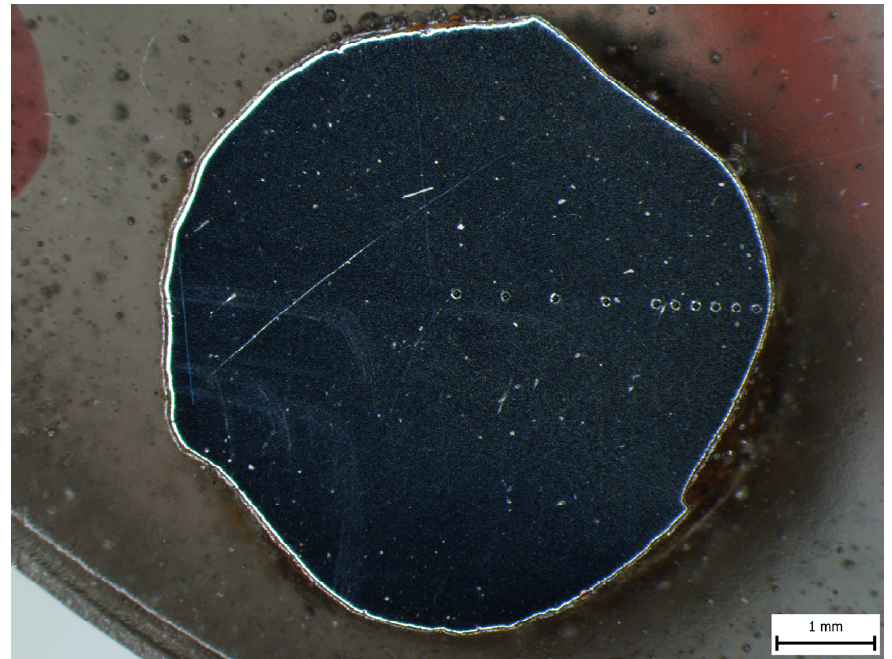
Figure 2. The cross-section of reinforcement φ 6 (B500 B). To describe the material response of the non-corroded reinforcement, 3 samples were created from B500 B φ 6 reinforcement without modifications (surface modification or